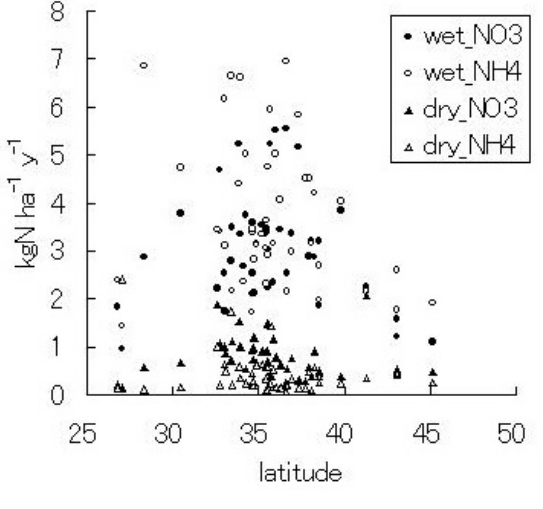
FIGURE 4 . Annual mean atmospheric N deposition from 1993 to 1997 (Japanese Environmental Agency and Acid Deposition and Oxidant Research Center, 1999). Closed and open circles represent wet deposition of nitrate and ammonium, respectively. Closed and open triangles represent dry deposition of nitrate and ammonium,